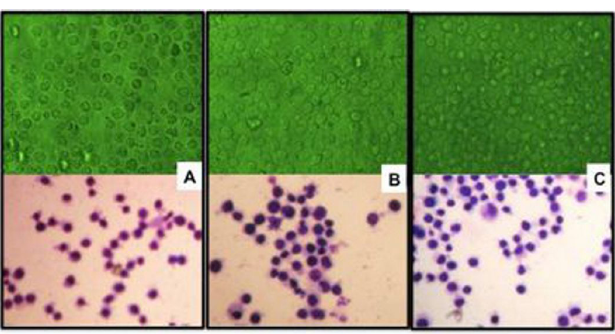
FIGURE 6 – K-562 cells at 24 h of exposure. Top row: living cells. Bottom row: cells fixed and stained with Giemsa after test completion. (A) Controls. (B) Placebo bilayer film. (C) Bilayer film containing